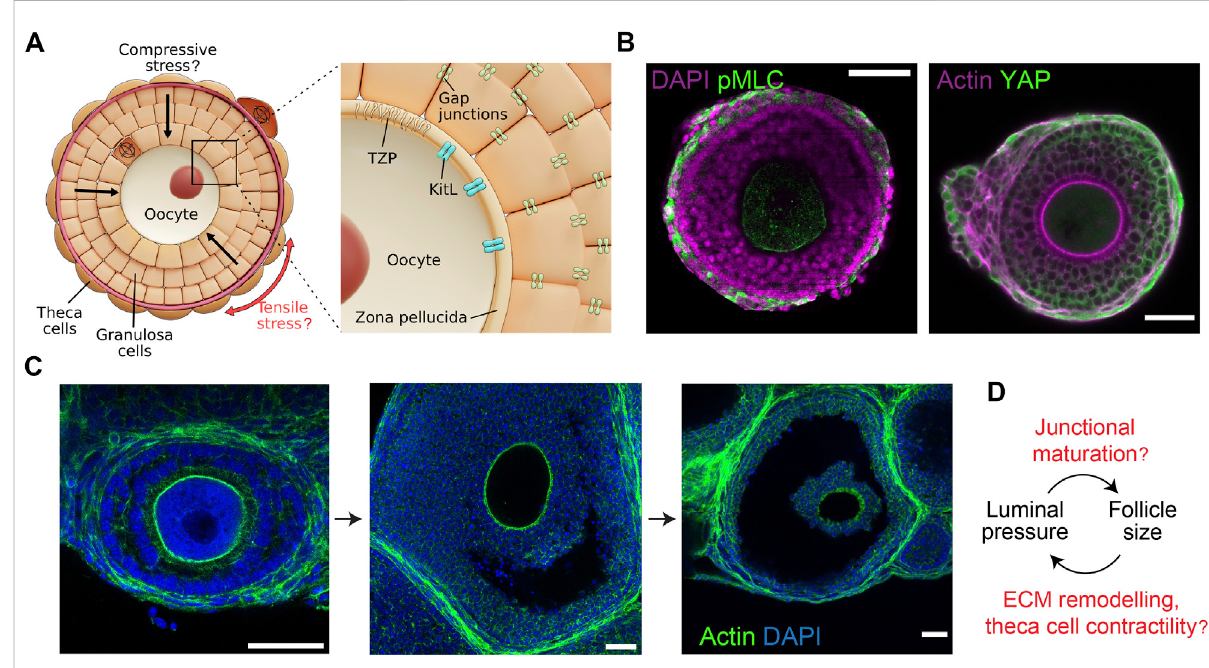
FIGURE 2 Mechano-hydrauliccontrolofsecondaryandantralfollicledevelopment. (A) .Duringsecondaryfollicledevelopment,spindle-shapedTCsform around the basement membrane(dark red) and theGCs, potentially generating compressive stress within the follicle. Anisotropicstress pattern may guide cell division orientation in the TCs (circumferential) and the GCs (radial). Inset: Compressive stress may affect oocyte growth by modifying the oocyte-granulosa interactions mediated by the TZP and Kit ligands. Mechanical stress may also in fl uence the GC proliferation via gap junction activities. (B) .Left:Isolated follicleimmuno-stainedfornuclei (DAPI)andphosphorylated-myosin lightchain(pMLC),showingcontractileTCs.Right: Follicle immuno-stained for actin and YAP, showing YAP nuclear localisation in the TCs only. Scale bar: 50 µm. (C) . Antral follicles immuno-stained for nuclei (DAPI) and actin. Luminal fl uid accumulates at the intercellular space, eventually merging into a singly-resolved antrum that continues to expand till ovulation. Scale bar: 40 µm. (D) . Potential feedback loop between luminal pressure and follicle size: increased luminal pressure may trigger junctional maturation and follicle expansion through mechanosensing, while TC stiffening may control the fi nal size of the